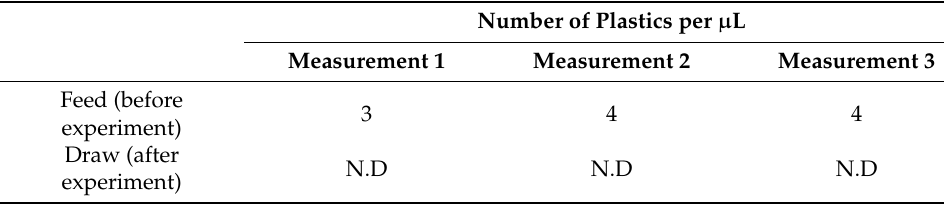
Table 3. Plastics present in feed and draw solutions of Group